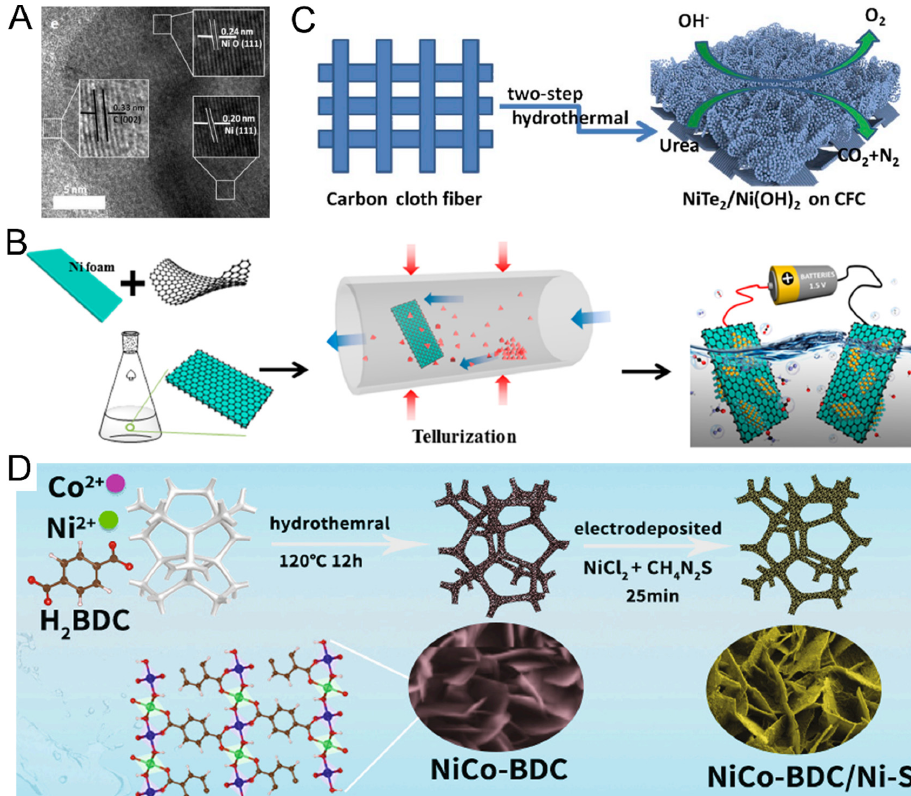
Figure 5. ( A ) TEM and HRTEM images of Ni – NiO/Gr – 450 °C [95]. Reproduced with